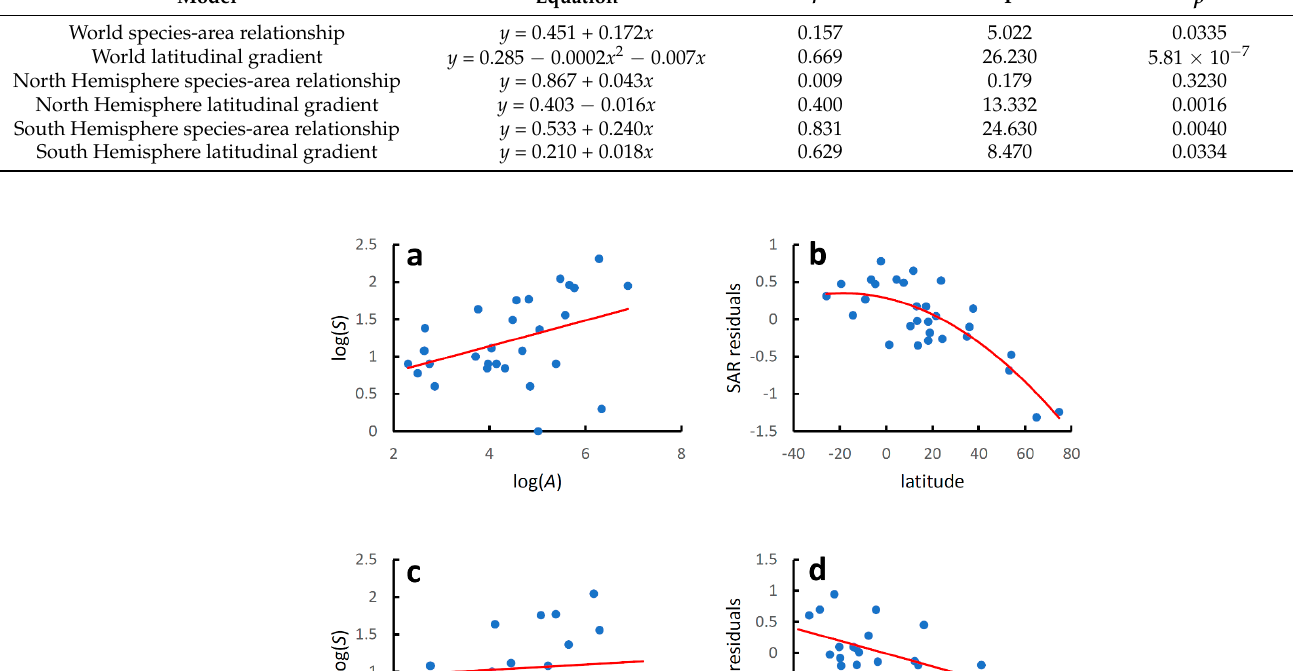
1.710) (Table 3, Figure 3d). For the Southern Hemisphere diversity increased linearly towards the equator (AICc for a quadratic model: 14.060; AICc for a linear model: 7.084;